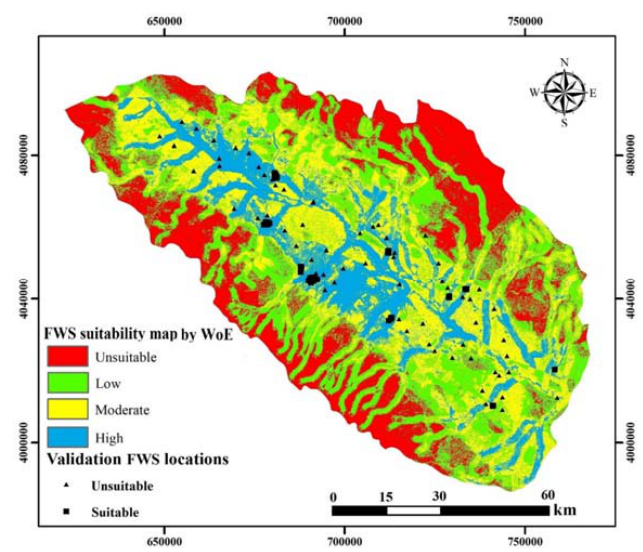
Figure 10. The FWS suitability maps produced by the WoE algorithm.